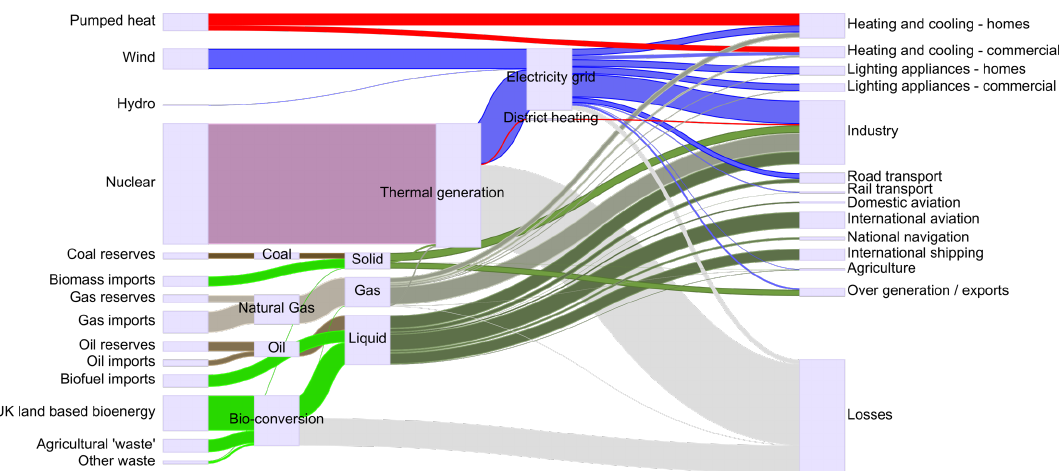
Figure 1. Energy flow diagram for 2050 scenario with high industrial energy demand before utilising nuclear reactors for direct process heat applications [21] (https://bit.ly/2nU7Iye).